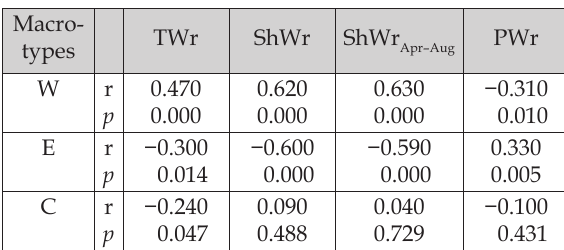
Table 4. Values of correlation coefficients (r) and their statistical significance ( p ) between the annual frequen - cy of W, E and C macro-types of the middle-tropo- spheric circulation and annual air temperature (TWr), annual sunshine duration (ShWr) and sunshine dura- tion of the long-day months. (ShWr ) and annual Apr–Aug precipitation (PWr) in Wrocław (1951–2018). Markings as in Table